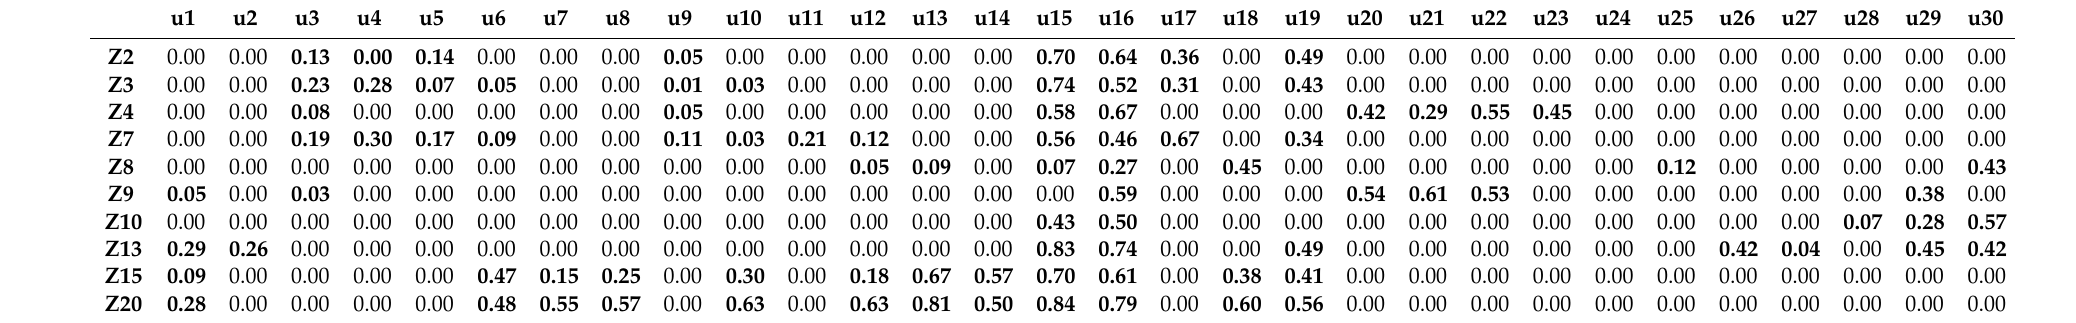
Table 3. Matrix of fuzzy relation R = Z × U for 10 selected building elements and their 30 characteristic types of